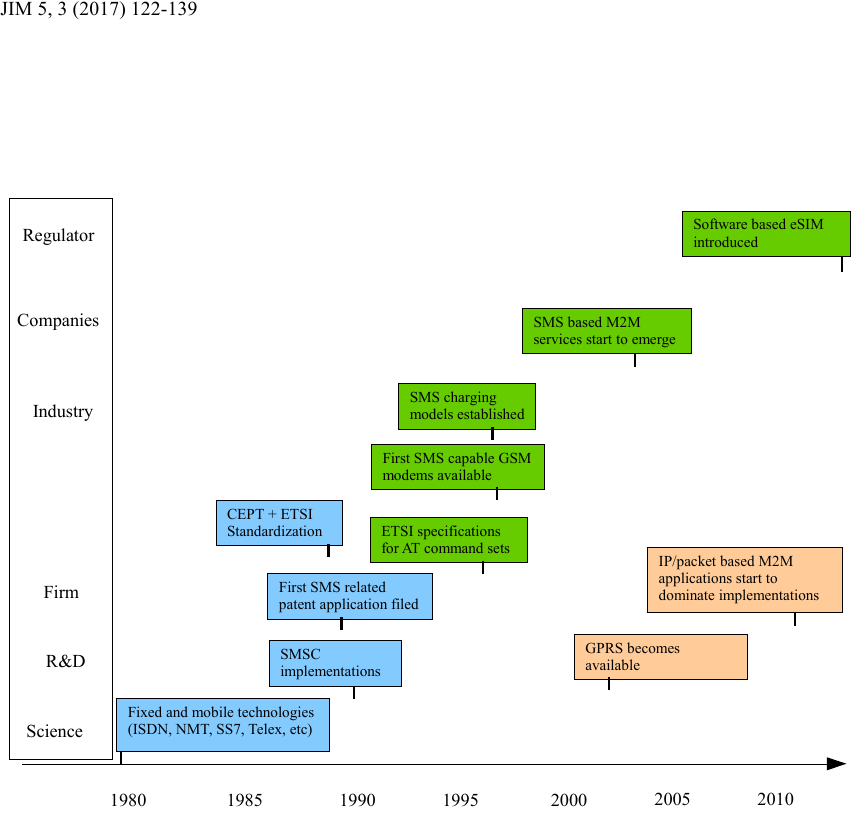
Fig. 5-a. Industry applications related events on the timeline on the different layers of the Disruption